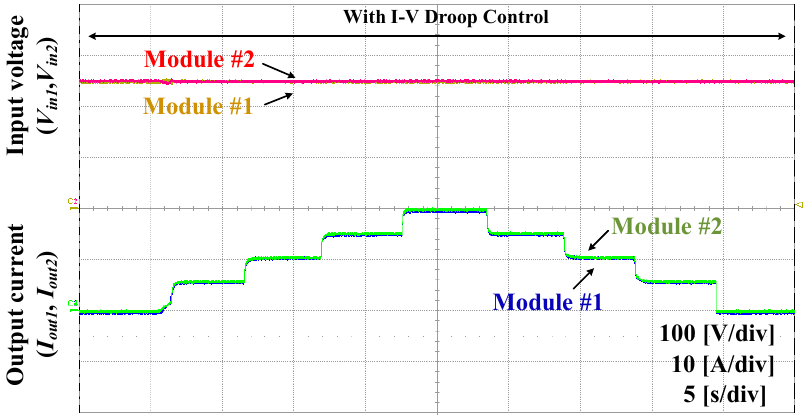
Figure 14. Experimental waveform of changed output current with proposed control method